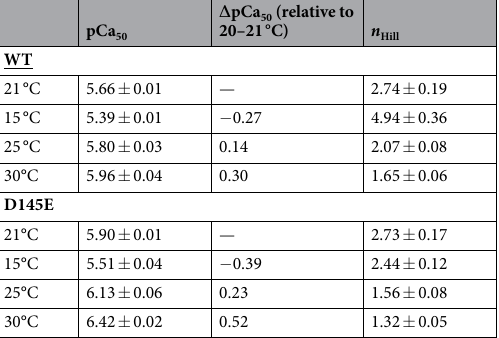
∆ pCa 50 (relative to 20–21 °C) n Hill pCa 50 WT 21 °C 5.66 ± 0.01 2.74 ± 0.19